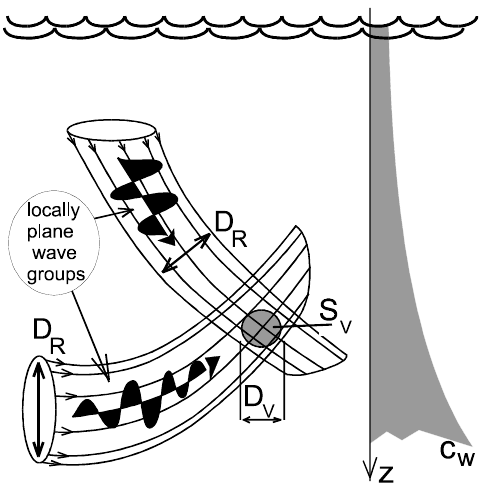
Figure 10. The protected body in the intersection of two tubes of rays with two incident wave groups (locally plane). This is in the undersea acoustical channel with non-uniform distribution c ( z ) (along the depth z ) of speed of propagation of acoustical w